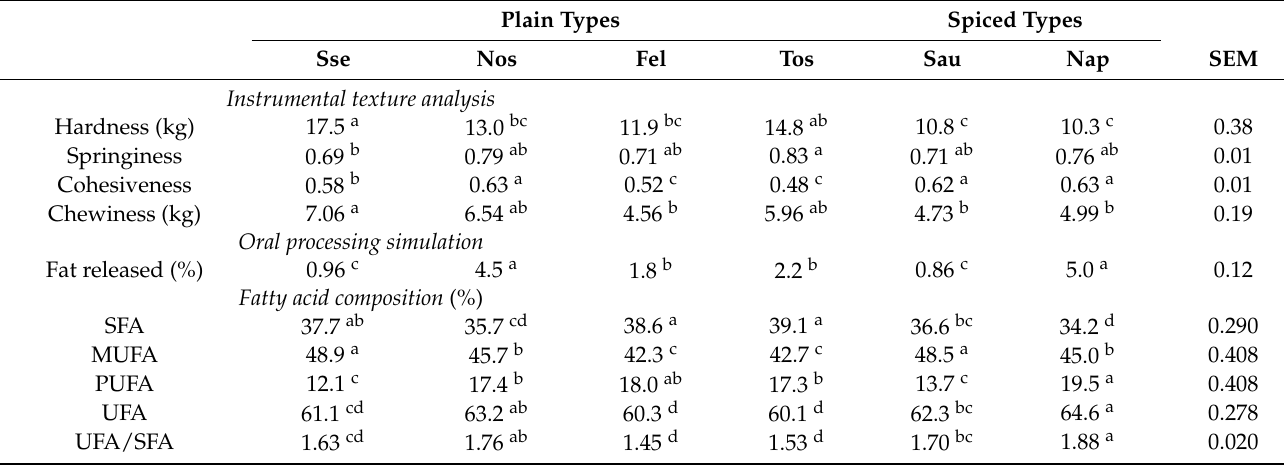
Table 4. Product texture attributes including instrumental texture analysis, amount of fat released (%), and fatty acid composition (% of total methyl esters) of six commercial fermented meat products ( n = 6). Plain Types Spiced Types Sse Nos Fel